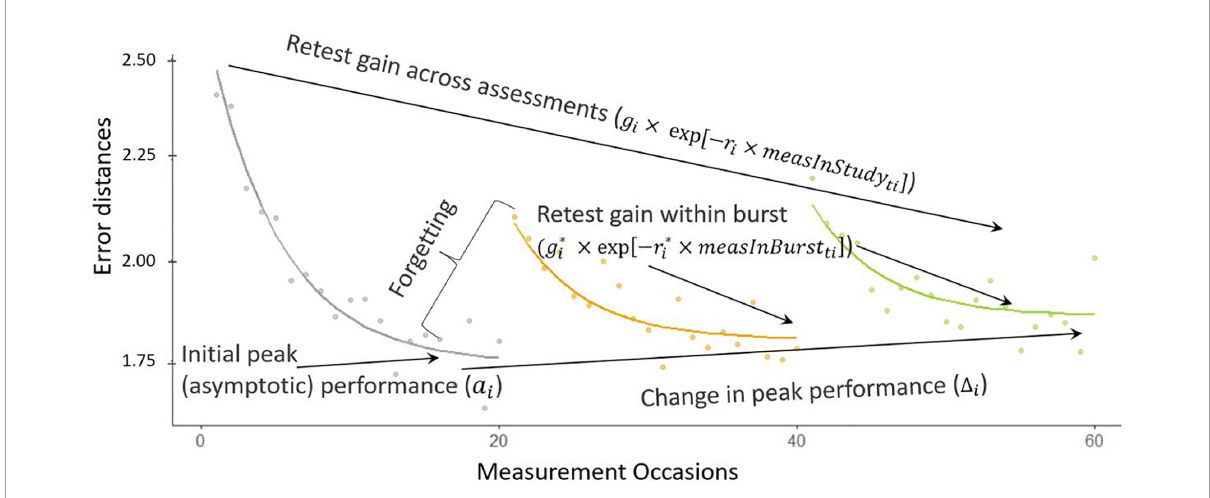
FIGURE5 Illustration of the double negative exponential